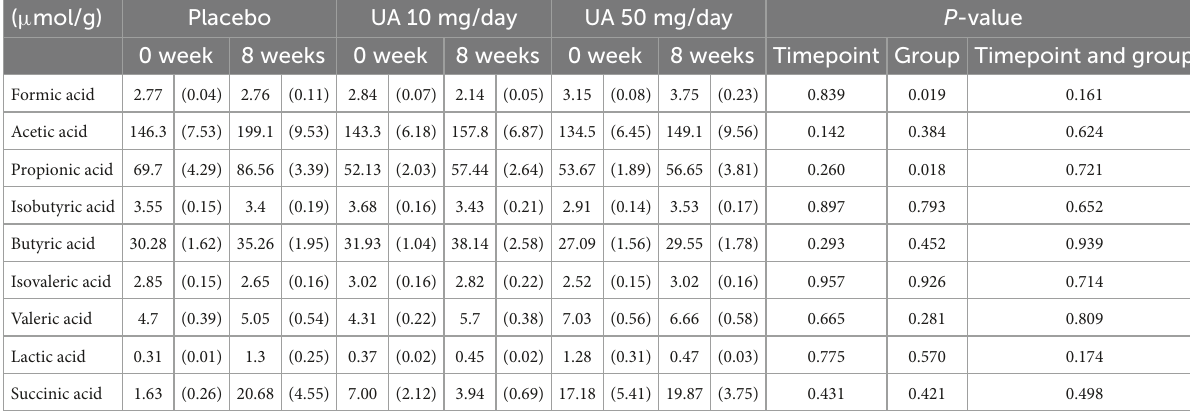
TABLE 1 Amount of organic acids in each